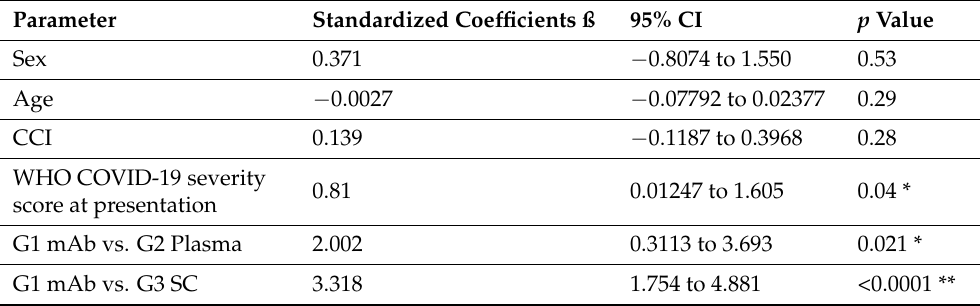
Table 2. Results of the regression model indicating the determinants of the COVID-19 severity defined by WHO score. Comparisons were considered significant at * p < 0.05 and ** p < 0.01. CCI =